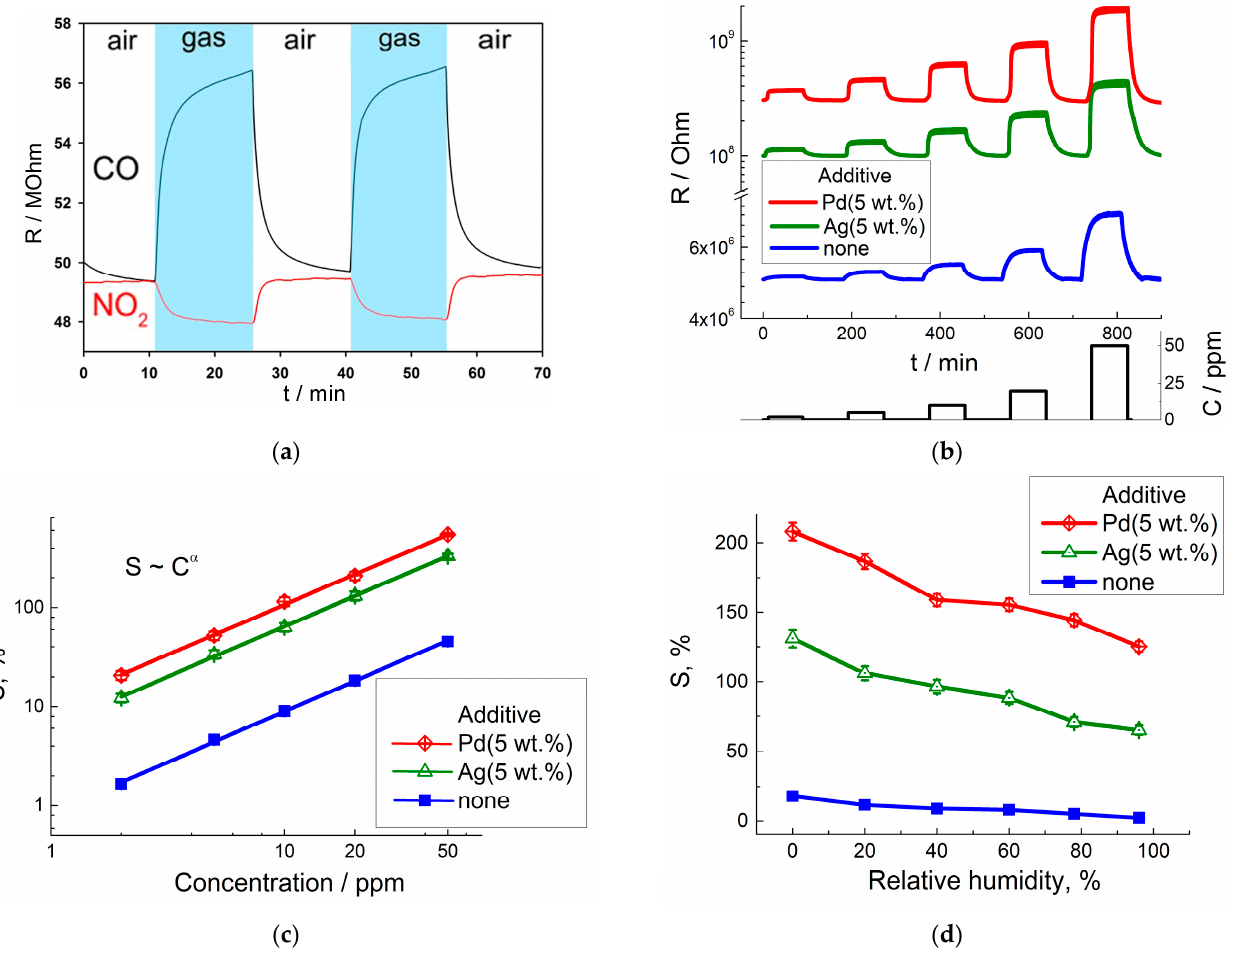
Figure 6. Dynamic sensor response of LaFeO 3 to 20 ppm CO and 1 ppm NO 2 at 200 °C ( a ); dynamic response to increasing concentration of CO for LaFeO 3 and LaFeO 3 /Ag(5 wt.%) at 200 °C and for LaFeO 3 /Pd(5 wt.%) at 150 °C ( b ); dependence of sensor signals on CO concentration for LaFeO 3 and LaFeO 3 /Ag(5 wt.%) at 200 °C and for LaFeO 3 /Pd(5 wt.%) at 150 °C ( c ); sensor signals of LaFeO 3 and LaFeO 3 /Ag(5 wt.%) at 200 °C and for LaFeO 3 /Pd(5 wt.%) at 150 °C to 20 ppm CO at different relative humidity levels ( d ).